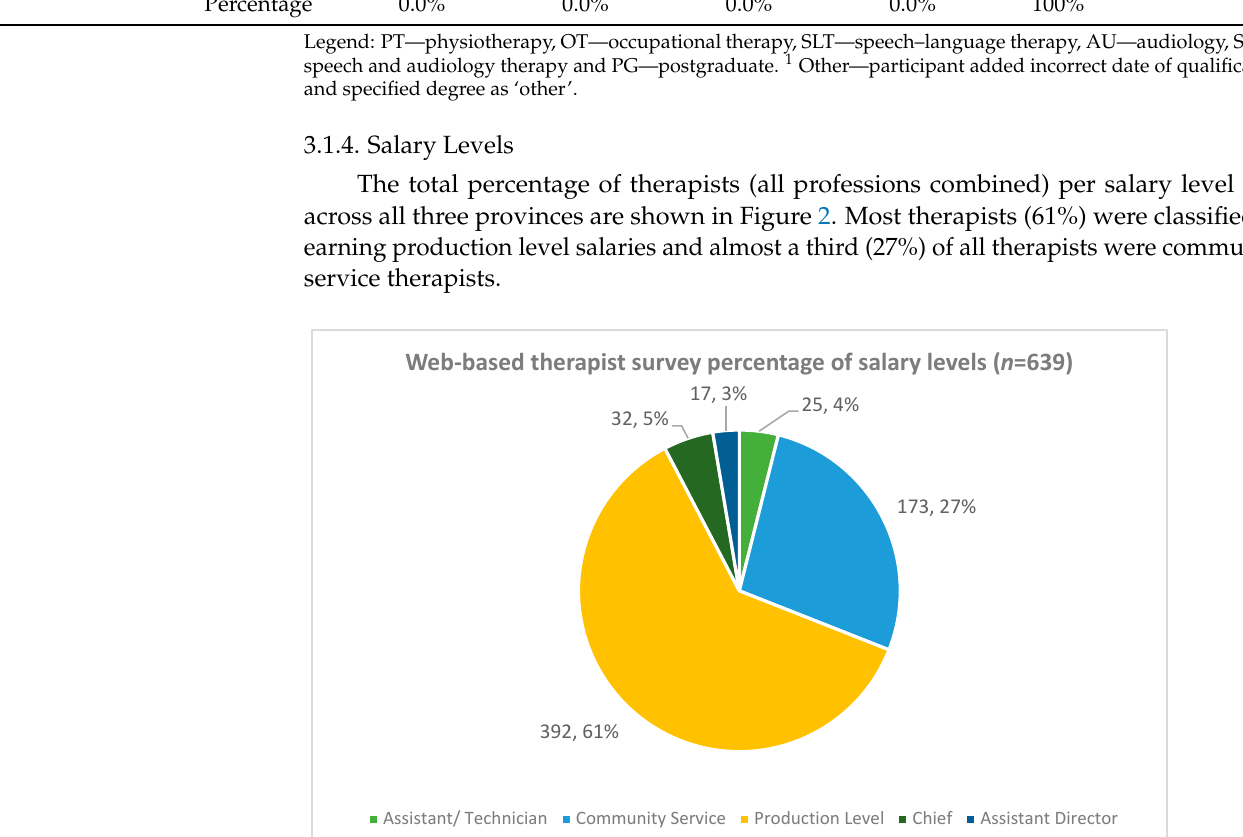
Figure 3. Distribution of salary levels per profession type. Legend: PT—physiotherapy, OT—occu- pational therapy, SLT—speech–language therapy, AU—audiology and SAT—speech and audiol- ogy therapy.